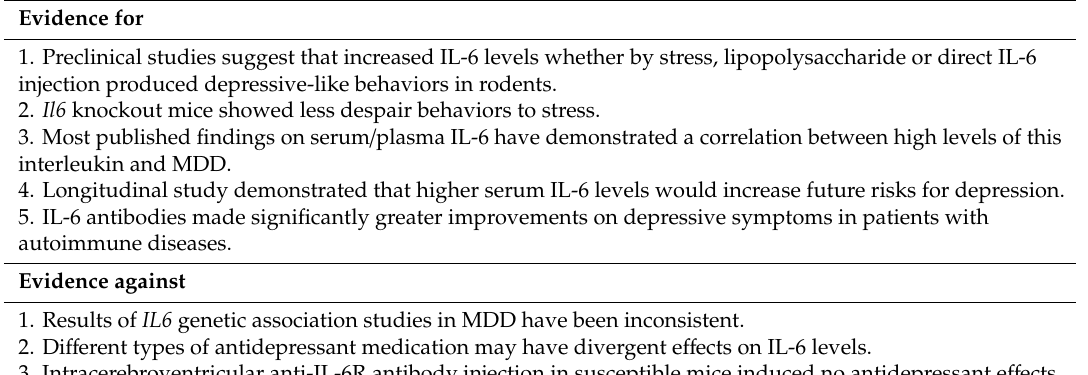
Table 2. Evidence for and against the role of IL-6 in